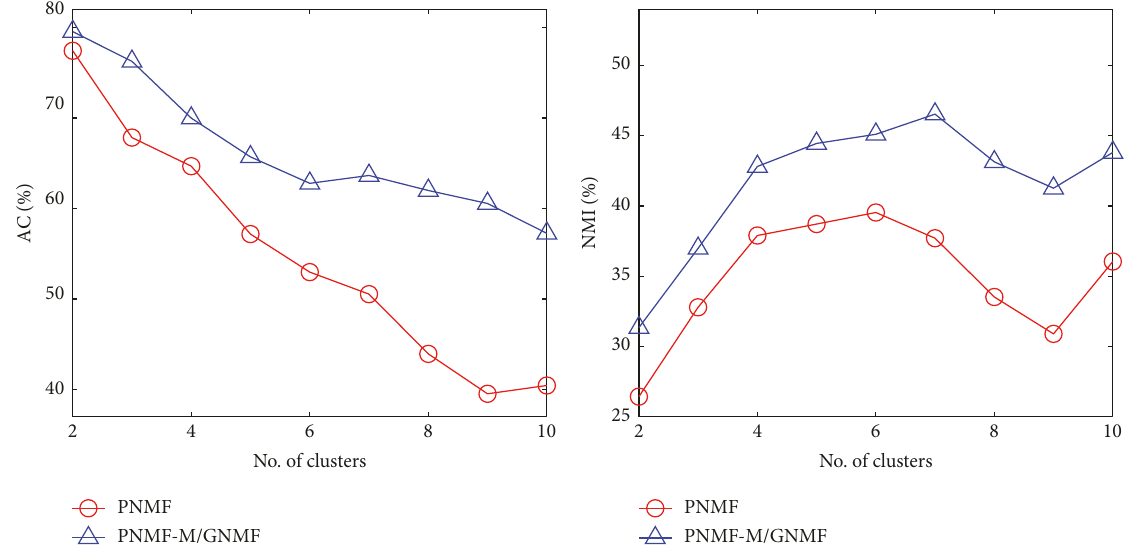
Figure 4: AC and NMI on Reuters.